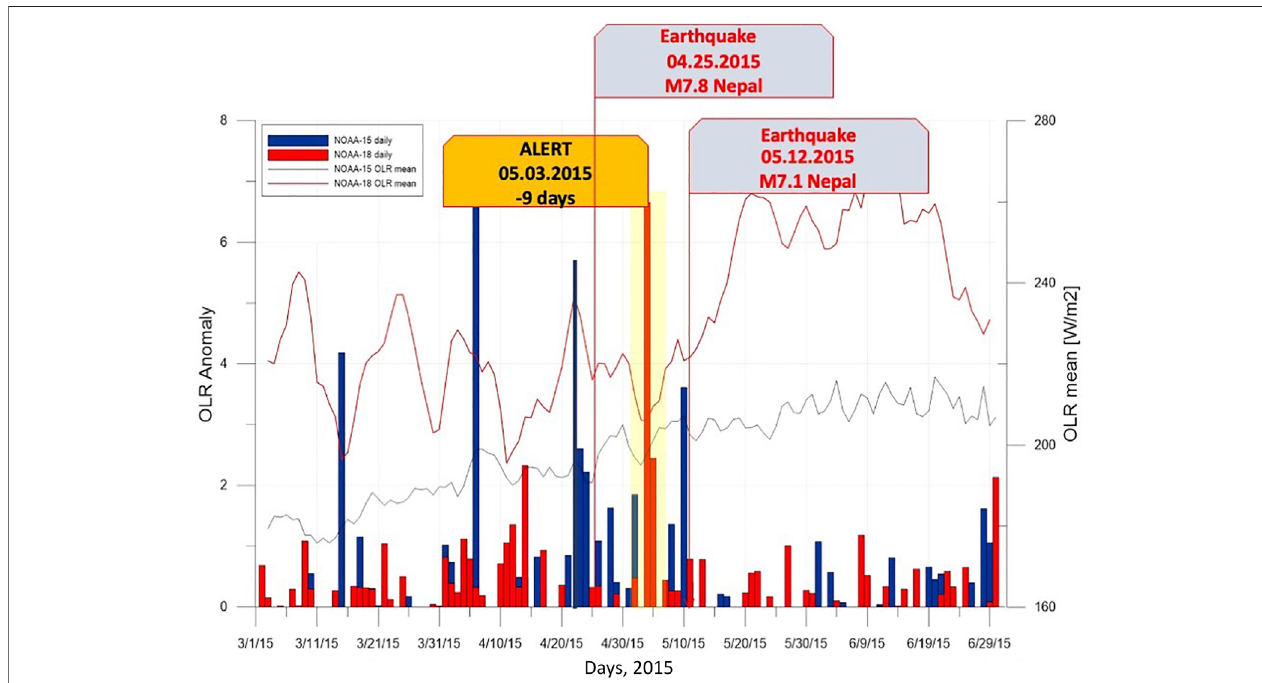
FIGURE6| TRAtimeseriesforMarch2015-June2015overth ’ l:e ’ j\ ’ JrGorkhaepicentralarea.OnApril5,2015andApril23,wererevealedtransientanomalies(by retrospective analysis of satellite radiation) 21 and 3 days in advance to the M7.8 mainshock of April 25, 2015, earthquake. On May 3, 2015, the ongoing prospective analysis of satellite radiation revealed transient anomaly (9 days in advance, with yellow), associated with the M7.3 of May 12, 20 15, earthquake.